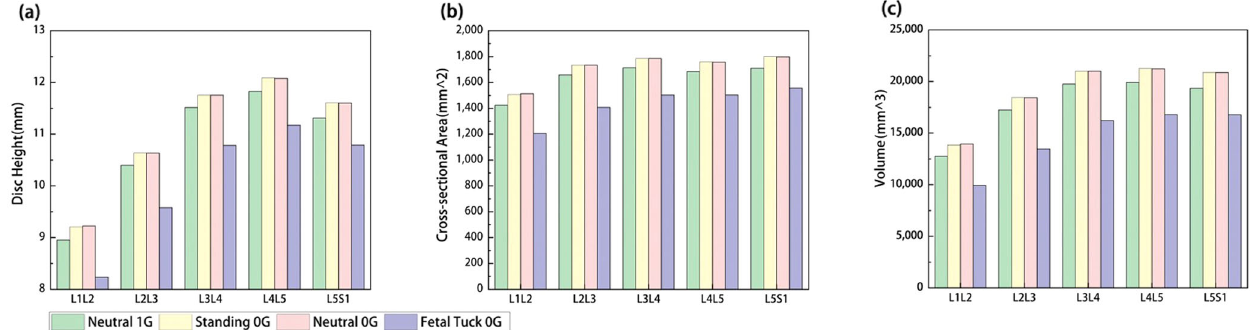
Fig. 3 Comparison of disc morphology change among various postures in 1G gravity and microgravity. a Disc height, b cross-sectional area, and c disc volume change among Neutral 1G, Standing 0G, Neutral 0G, and Fetal Tuck 0G.